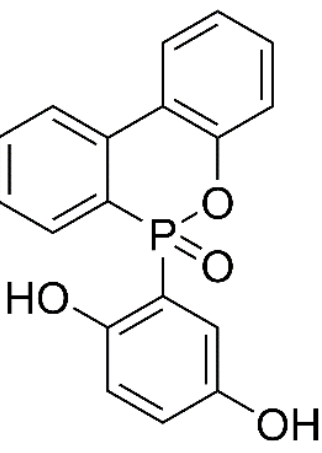
Figure 1. The Structural Formula for DOPO-HQ(DQ).